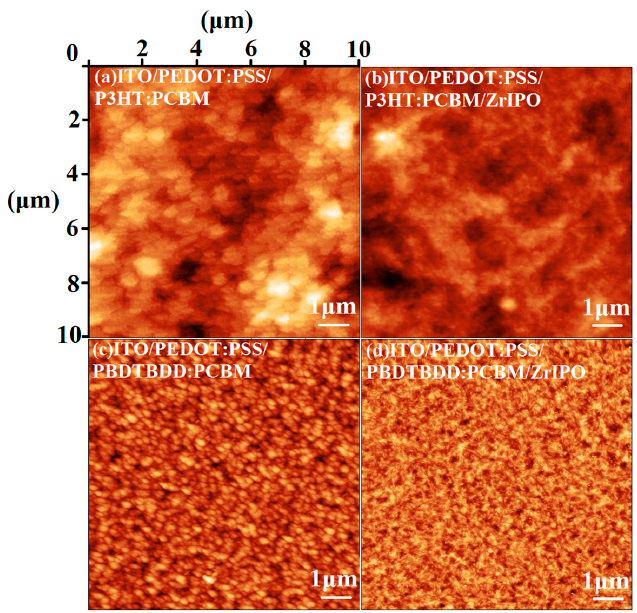
Figure 4. Atomic force microscope ( AFM) images of ( a , b ) P3HT:PCBM and ( c , d ) PBDTBDD:PCBM photoactive layer without and with ZrIPO cathode modification layer on ITO/PEDOT:PSS substrates, respectively, with 10 μ m × 10 μ m scan size.